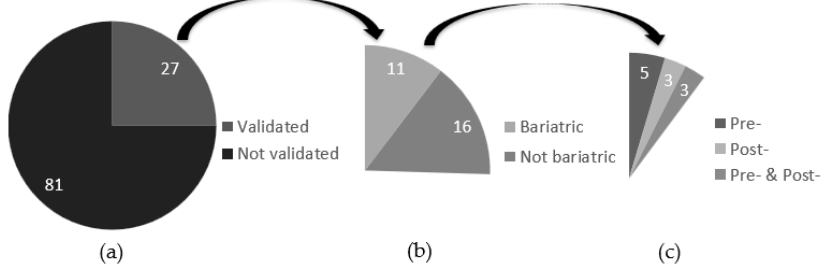
Figure 2. ( a ) Number of tools validated and not validated; ( b ) Number of tools validated within a bariatric population; ( c ) Number of tools validated pre- and post- bariatric surgery.